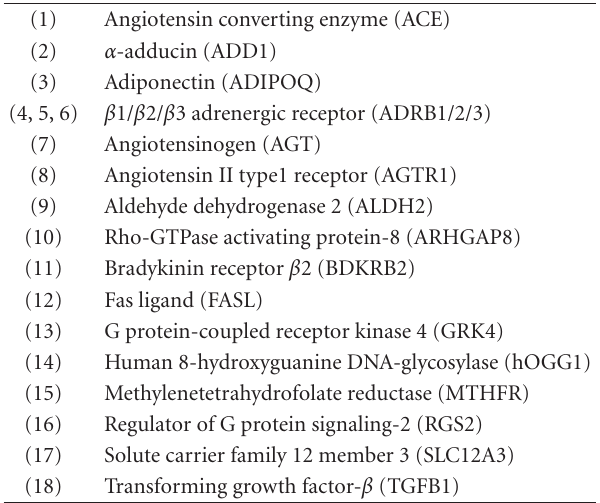
Table 1: Susceptible genes for